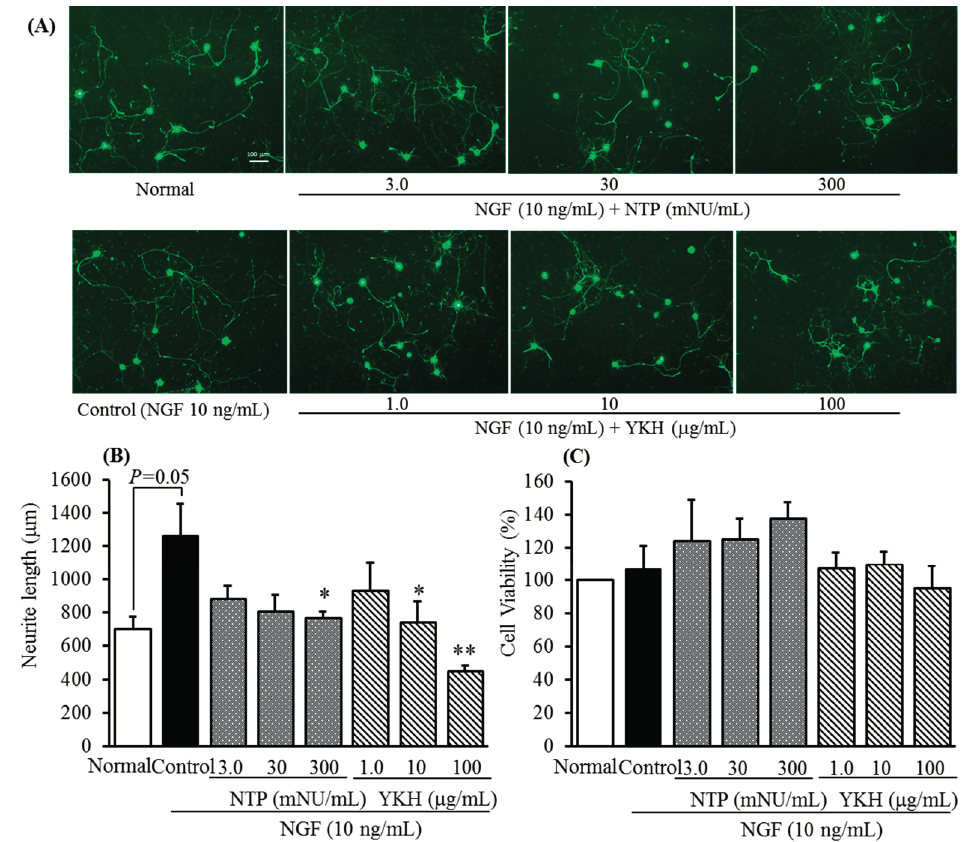
Figure 2. Inhibitory activities of Neurotropin ® (NTP, as a positive control) and yokukansankachimpihange (YKH) against NGF-induced neurite growth ( A ) representative images of DRG neurons from normal or NGF treated culture with test samples that showed peripherin immunofluorescence. Scale bar = 100 μ m; ( B ) neurite elongation was calculated on the basis of length of all neurites) and cell cytotoxicity in cultured DRG neurons; ( C ). Values are the means ± S.E.M. of triplicate experiments. Normal vs. Control with Student’s t -test. * p < 0.05, ** p < 0.01 vs . Control (Dunnett’s